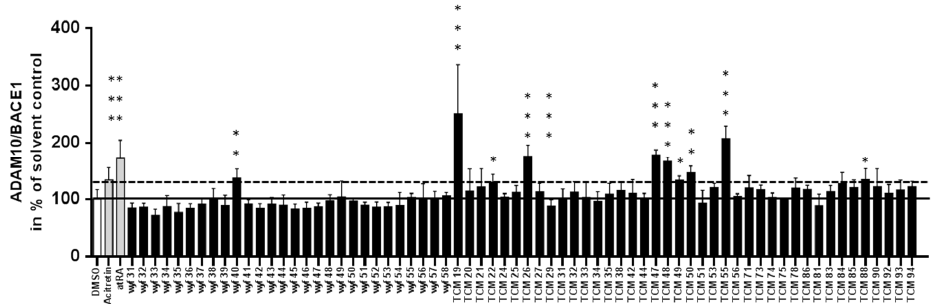
Figure 2. Influence of tested substances on ADAM10/BACE-1 promoter activity ratio. Cells were incubated for 48 h with substances according to results from toxicity assay (see Figure 1). DMSO (solvent) and known activators of ADAM10 promoter activity (Acitretin and all-trans retinoic acid, both 1 μ M, [34]) served as controls. The dashed line indicates the minimal effect size expected for a “hit” (values > mean + SD (130%) of control-treated cells). Values ± SD were collected from three independent experiments (statistical analysis: one-way ANOVA with Bonferroni’s multiple comparison test; ***, p < 0.001; **, p < 0.01; *, p <